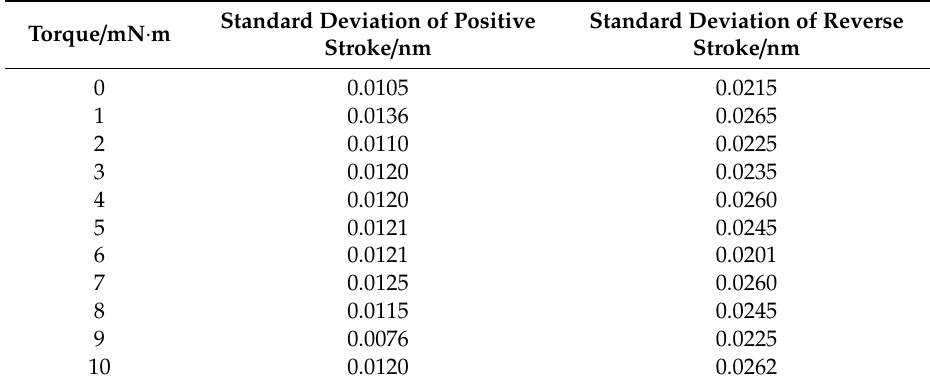
Table 2. Standard deviation of each torque gradient in the same stroke.